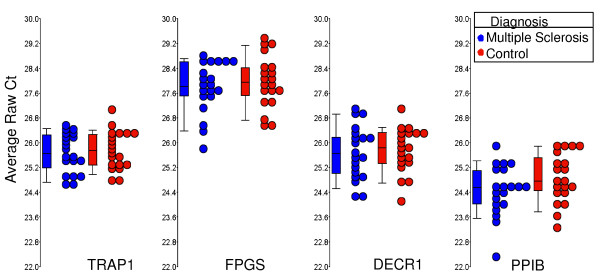
RNA expression values are shown for the four most stably expressed genes (TRAP1, FPGS, DECR1 and PPIB) for multiple sclerosis (MS) and controls subjects. Circles represent individual qRT-PCR Ct average raw values for MS samples (blue, n = 20) and age and gender matched controls (red, n = 20). Boxes represent the 25th and 75th quartile and lines represent the median. Whiskers represent the range of data for the 10th and 90th quartile.